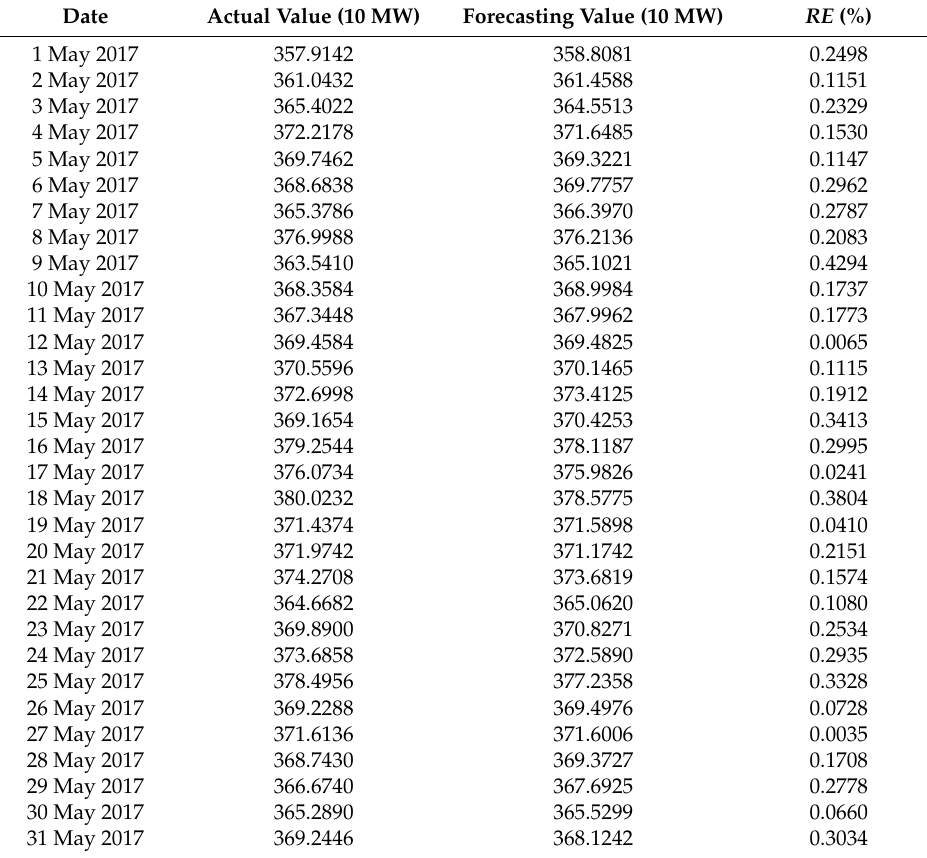
Table 3. The relative errors of forecasting